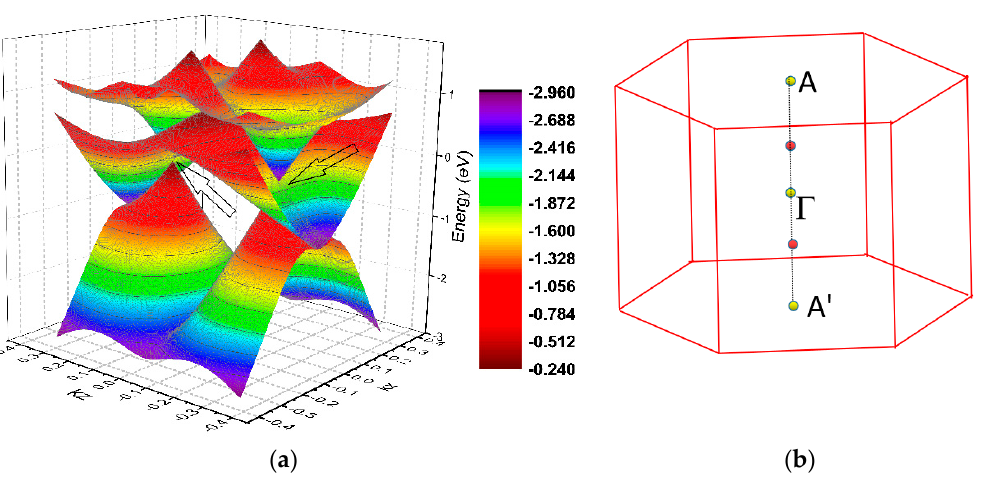
Figure 7. ( a ) 3D band dispersion along the A’– Γ –A paths in the k y = 0 plane. The arrows show the profile of the triply degenerate points and ( b ) the position of the triply degenerate points in the 3D Brillouin zone (BZ). The triply degenerate nodal points are highlighted using red balls.